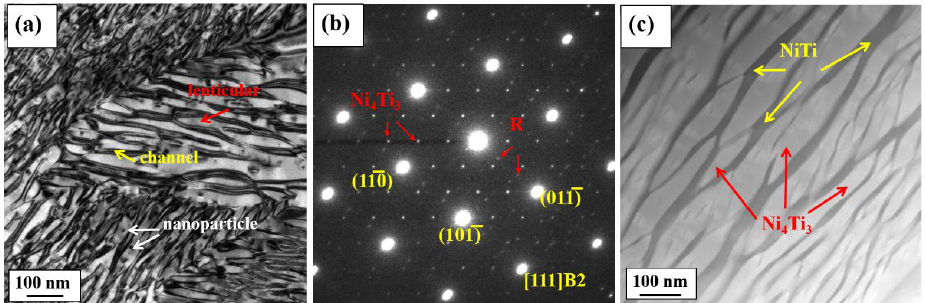
Figure 3. ( a ) TEM bright-field image of 60NiTi; ( b ) the corresponding selected area electron diffraction (SAED) along the [111] B2 axis; and ( c ) the STEM image.